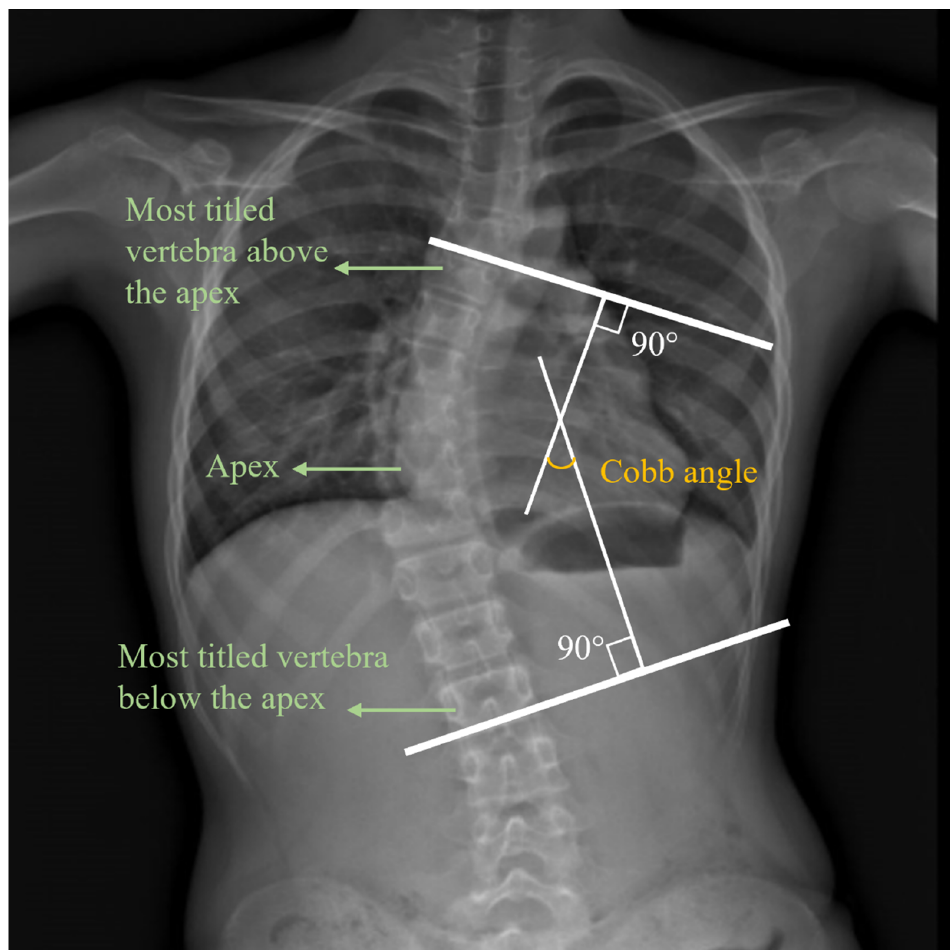
Figure 1. An x-ray image of the Cobb angle . Figure 1. An X-ray image of the Cobb